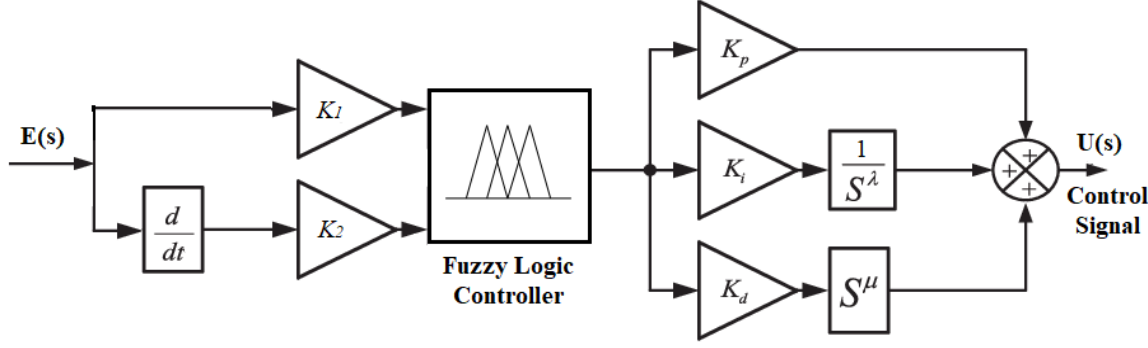
Figure 8. Block diagram of the fuzzy FOPID controller.